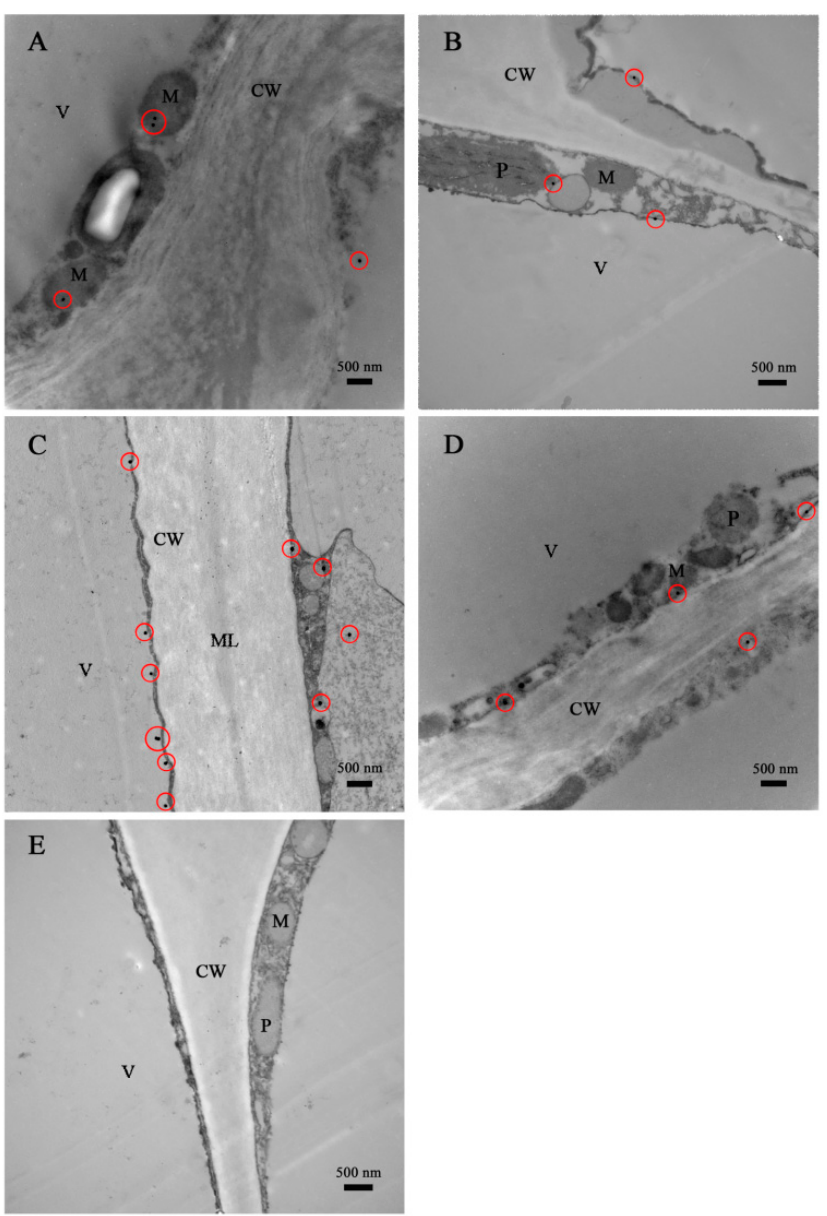
Figure 4. Immunogold electron microscopy localization of DkLOX3 in persimmon fruits from two cultivars during storage. ( A ) “Fupingjianshi”; ( B ) “Ganmaokui”; ( C ) “Fupingjianshi”; ( D ) “Ganmaokui”; ( E ) control; ( A , B ) after harvest; ( C , D ) after 12 days of storage. CW cell wall, ML middle lamella, M mitochondrion, V vacuole, P plastid. Gold particles are encircled in red. ( A ) 20,000×; ( B ) 25,000×; ( C ) 20,000×; ( D ) 20,000×; ( E ) 25,000×.